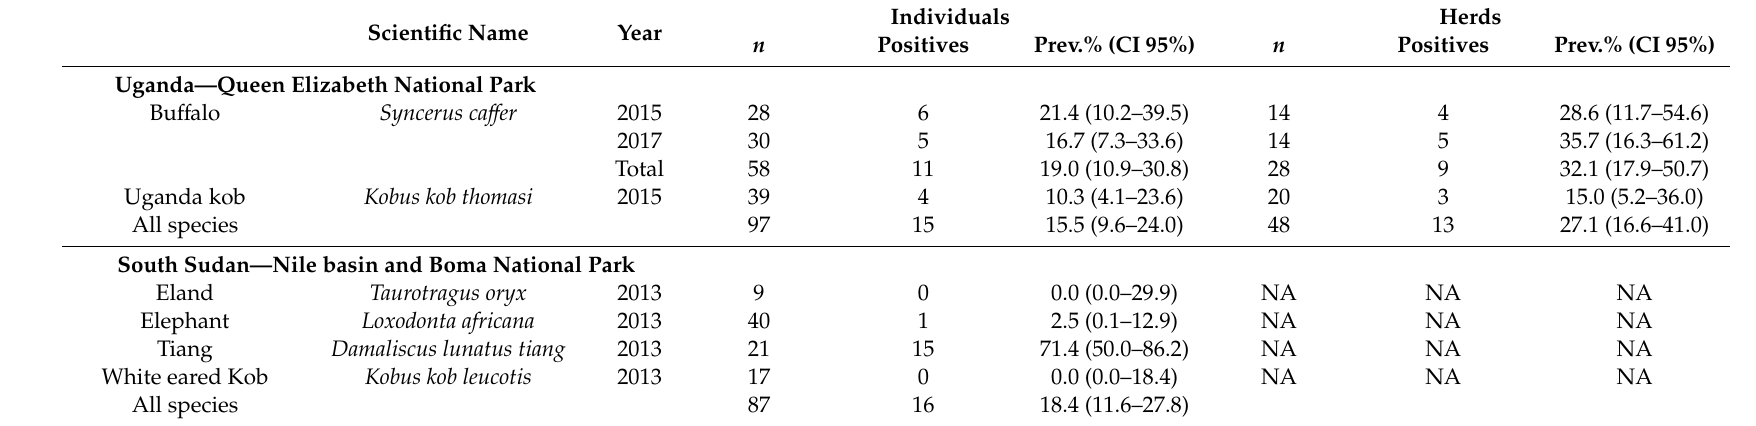
Table 1. Results of peste des petits ruminants virus (PPRV) antibody detection in sera from apparently healthy wild ungulates captured in Queen Elizabeth National Park, Uganda in January 2015 and October 2017, and in Nile basin and Boma National Park, South Sudan in